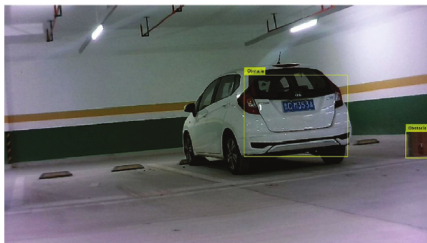
Figure 5: Obstacle extraction.